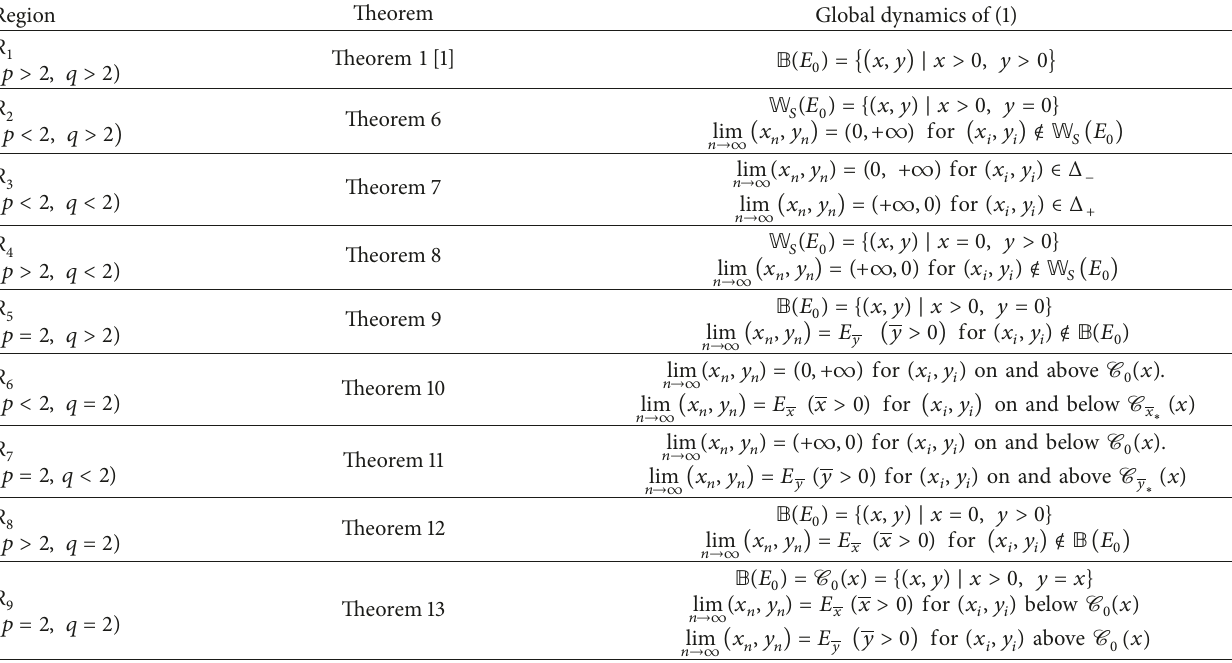
Table 2: Global dynamics of